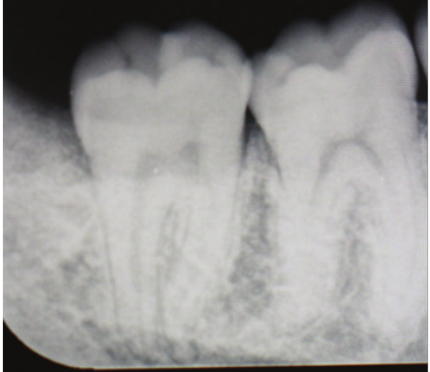
Figure 6: Postoperative periapical X-ray of the lower right second